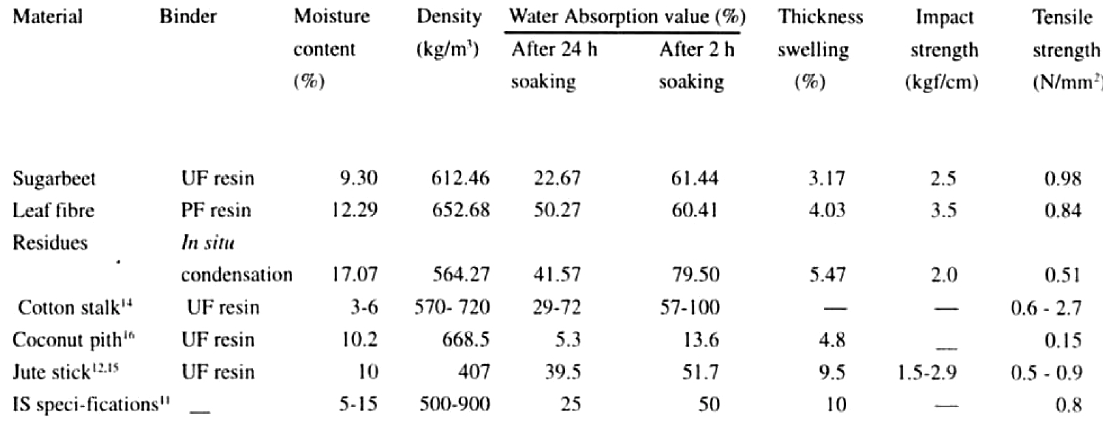
Figure 16. Physicomechanical features of different particleboards [61].